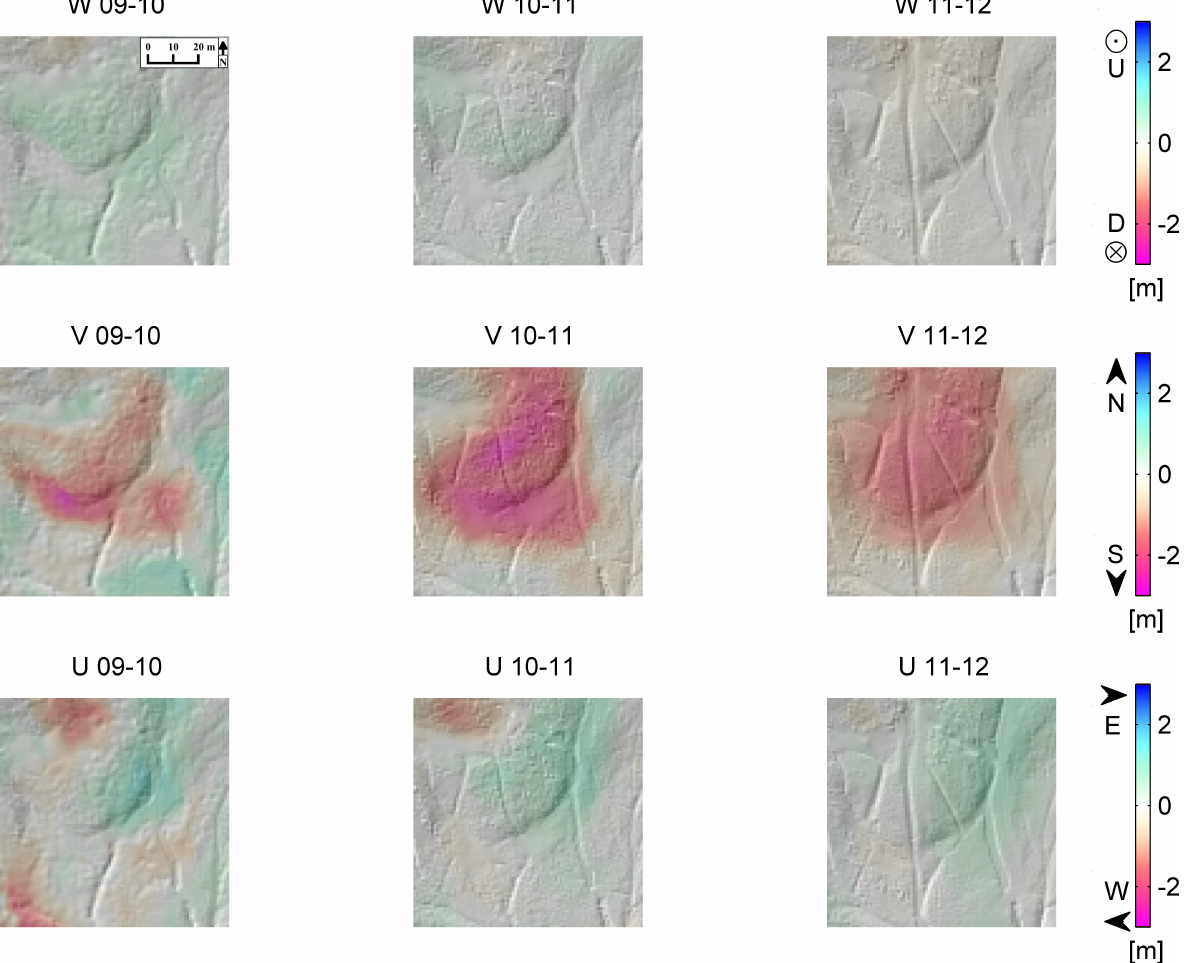
Figure 13. Mid-slope motion vectors from 2009 to 2012, W . . . elevation change, U . . . west- east motion, V . . . south-north